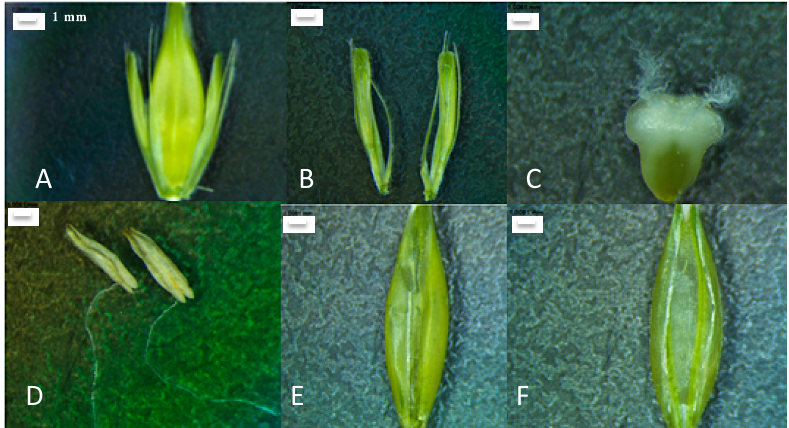
Figure 1. Isolated barley flower and its organs. ( A ) Barley flower. ( B ) Lateral spikelets. ( C ) Caryopsis. ( D ) Stamens. ( E ) Lemma. ( F ) Palea. Scale—1 mm.